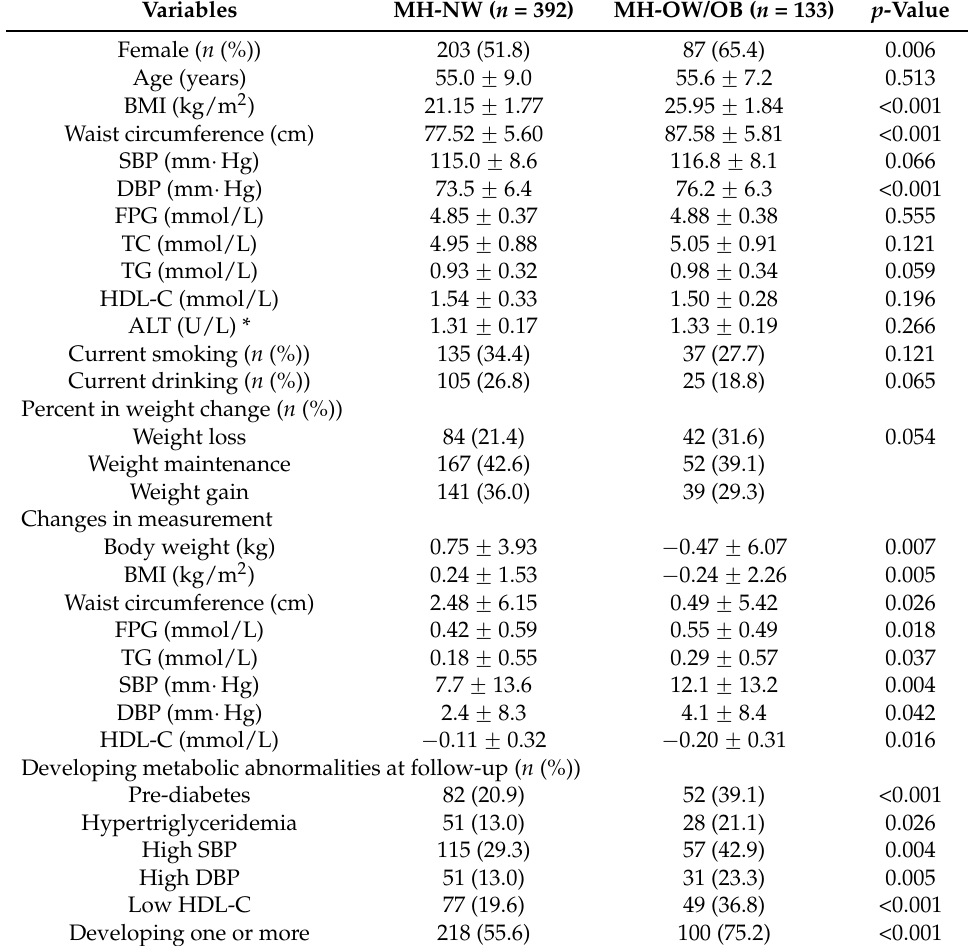
Table 1. Characteristics of the metabolically healthy normal-weight (MH-NW) and metabolically healthy overweight/obese (MH-OW/OB) subjects at baseline and the incidences of the metabolic abnormalities at